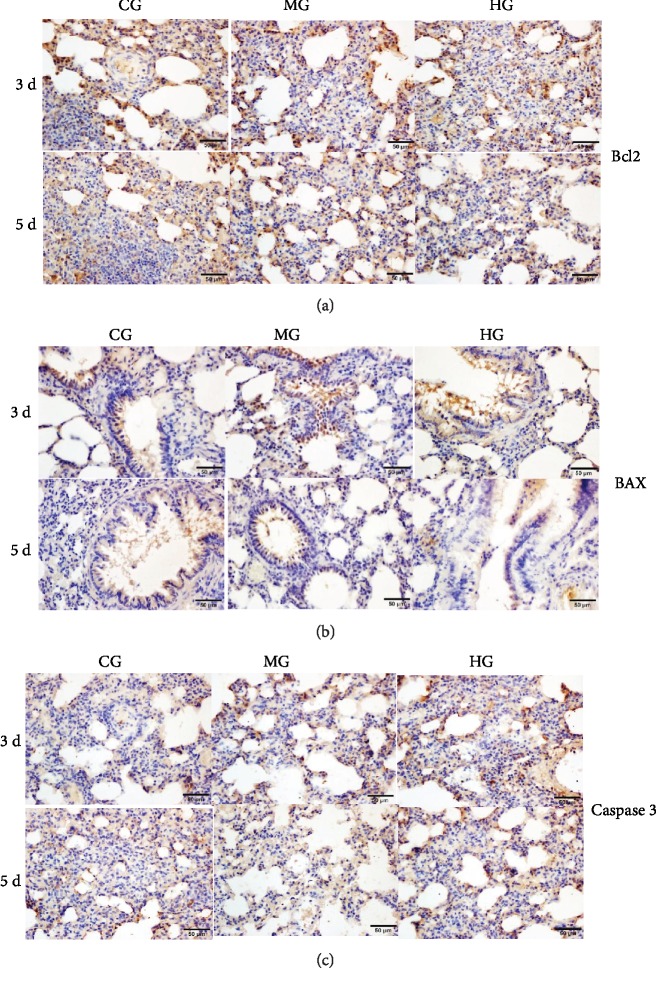
Immunohistochemical analysis of the effects of hydrostatin-SN10 on apoptotic markers (Bcl2, BAX, and caspase 3). (a) Bcl2. (b) BAX. (c) Caspase 3 n = 12 for each group, and statistical difference was significant if p < 0.05.